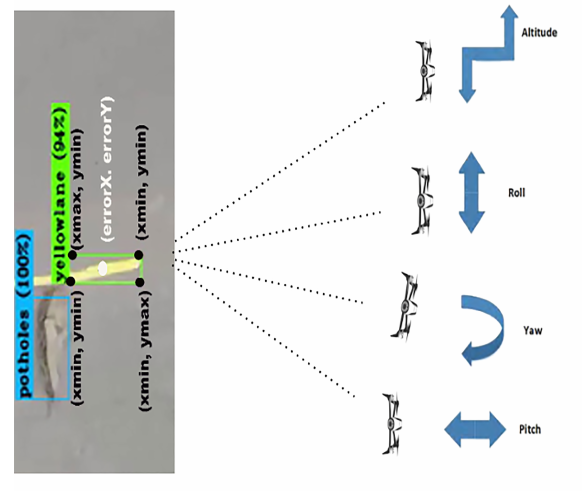
Figure 10. Autonomous UAV